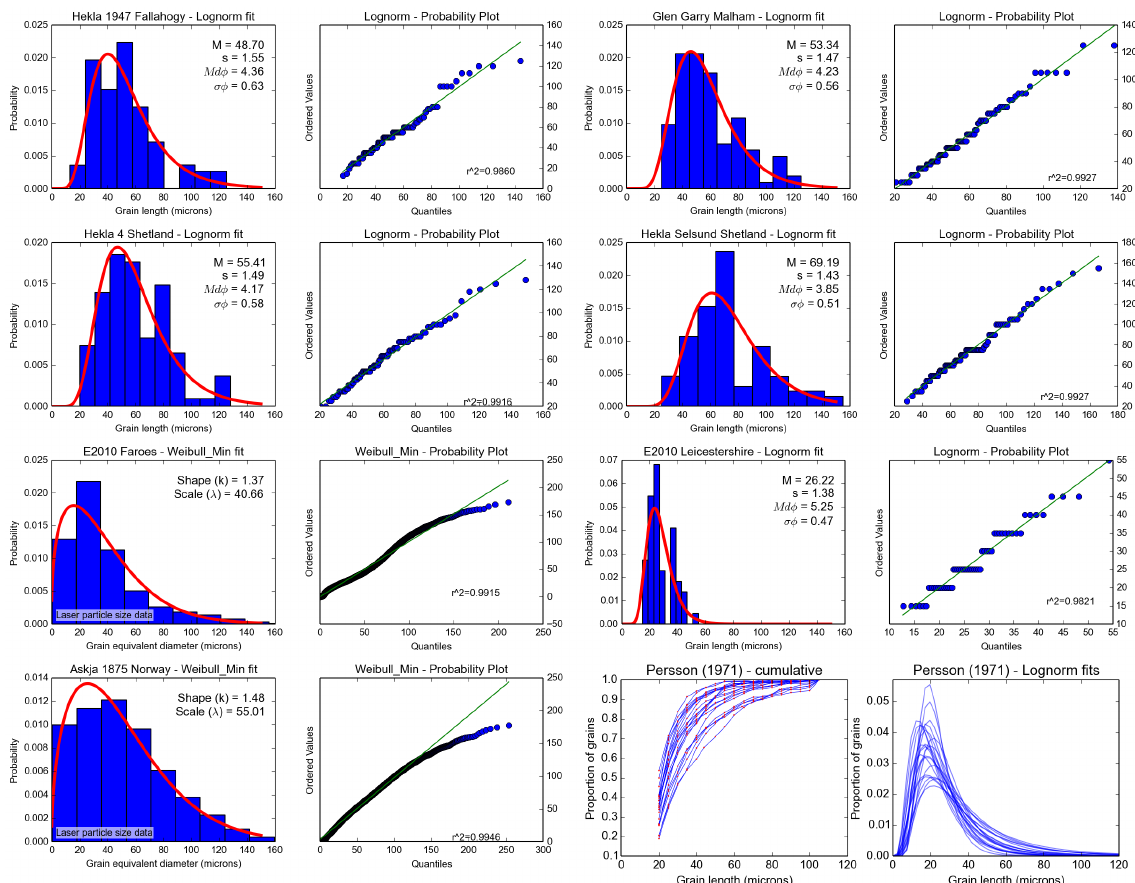
Figure 3. Statistical model fits to distal tephra grain-size distributions. Optical microscope cryptotephra lengths are well characterised by a lognormal distribution. Coulter counter data (Askja 1875 Norway, Eyjafjallajökull 2010 Faroes), which have a fine tail, are better fit by Weibull distributions. Data from Persson (1971) are shown for comparison. See Supplement for additional